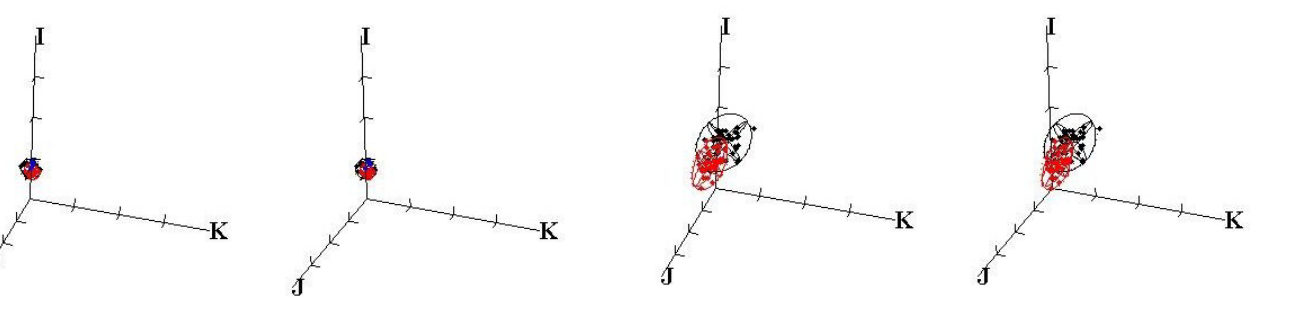
Figure 1. Stereo-pair scatter plot (with included 95% distribu- tion ellipsoids) of the three sets of measurements taken on the test eye. The first set is represented by the black data points, the second set is represented by the red data points and the third set is represented by the blue data points. The origin is 42 I D.